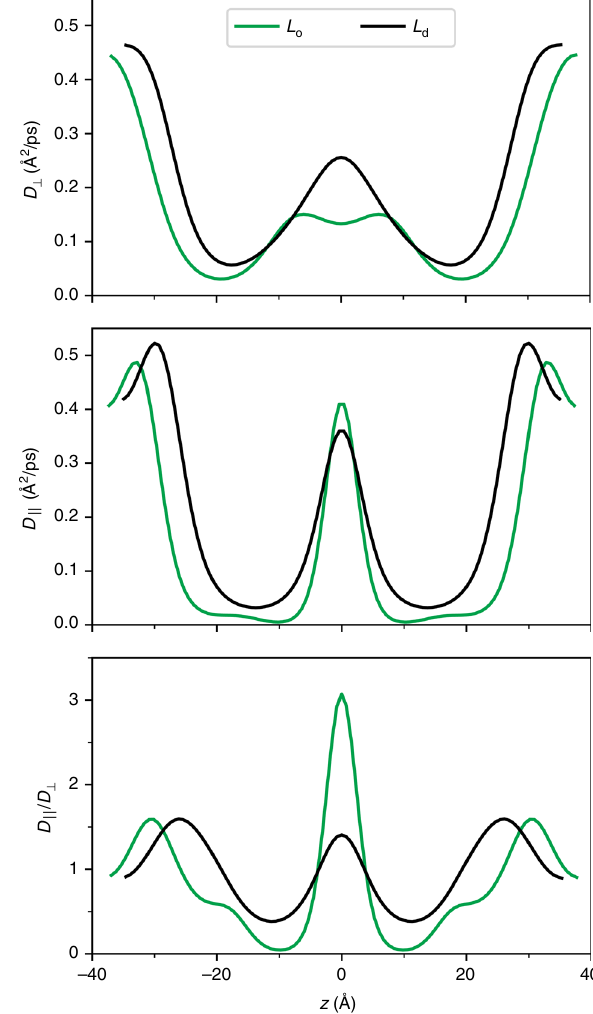
Fig. 3 Diffusion pro fi les for oxygen. Pro fi les normal D ? ð z Þ (top) and parallel D jj ð z Þ (center) to the membrane surface in the L o and L d phases were obtained from BA. The anisotropy is the ratio D jj ð z Þ = D ? ð z Þ (bottom). Source data are provided as a Source Data fi le.